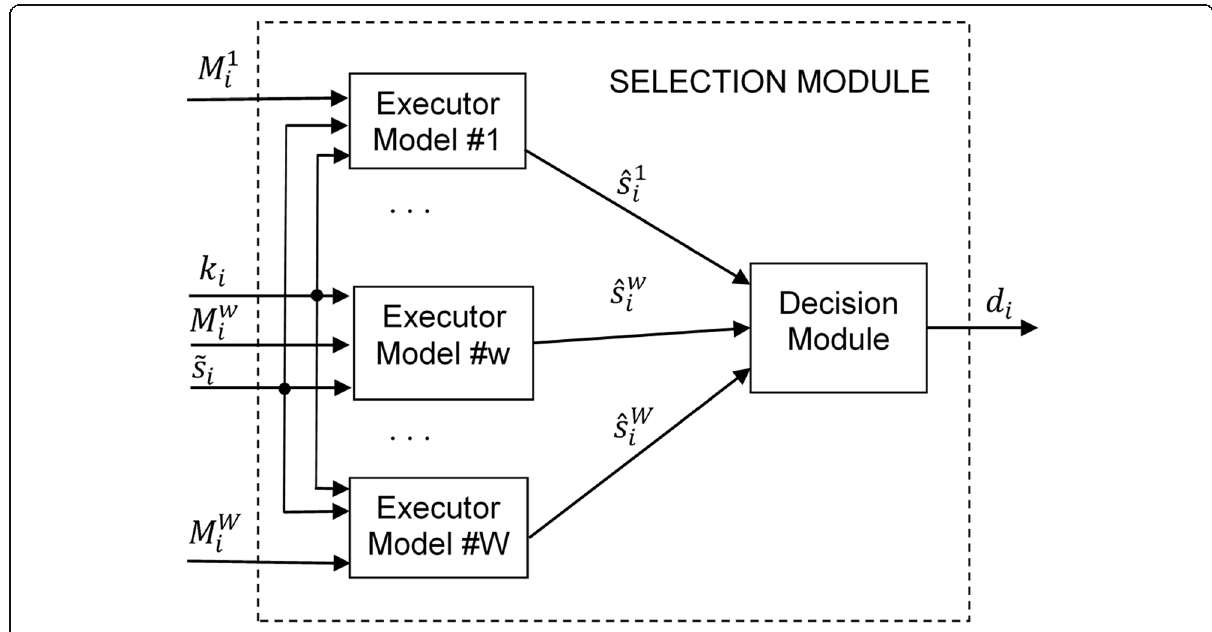
Fig. 4 Design of the selection